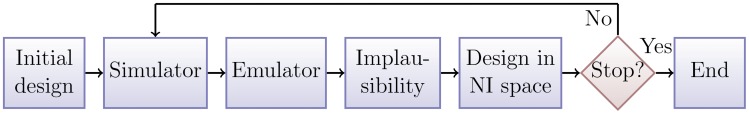
History matching workflow.The simulator is evaluated at carefully selected design points. Its output is used to train the emulator, which, with the help of the implausibility measure, determines the parts of the input space which are non-implausible (NI). The simulator is then evaluated at set of design points from the non-implausible space and the procedure is repeated until one or more stopping criteria are met.